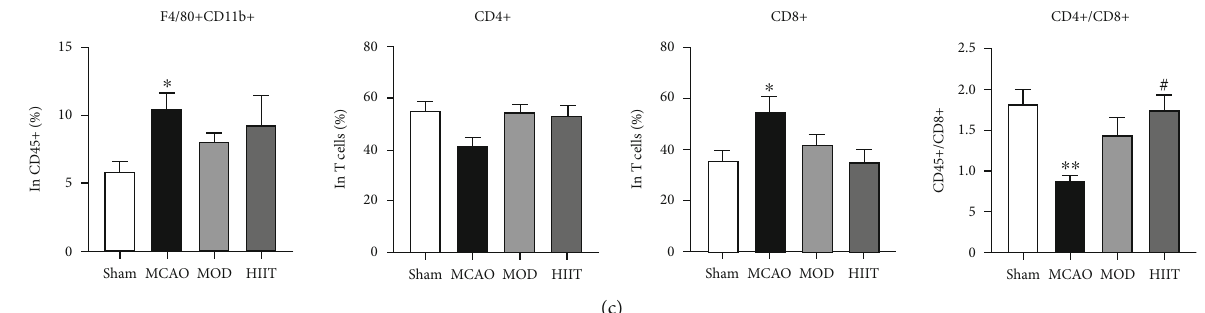
Figure 8: Level of cytokines in paretic skeletal muscle and lymphocyte subsets in peripheral blood. (a) The pro fi les of multiple cytokines in paretic gastrocnemius muscle in each group, including interleukin- (IL-) 1 α , IL-1 β , IL-6, IL-10, IL-27, monocyte chemoattractant protein (MCP-1), tumor necrosis factor- (TNF-) α , and interferon- (IFN-) γ . (b) Representative fl uorescence activated cell sorting (FACS) plots of F4/80+CD11b+ macrophages gated on CD45+ cells, CD4+ cells gated on CD45+CD3+ cells, and CD8+ cells gated on CD45+CD3 +cells in muscle tissue. (c) Bar graph showing the percentage of F4/80+CD11b+ cells in CD45+ cells, CD4+ cells in CD45+CD3+ cells, CD8+ cells in CD45+CD3+ cells, and the ratio of CD4+ and CD8+ cells. Values are expressed as the mean ± SEM of the mean. ∗ P < 0 : 05 and ∗∗ P < 0 : 01 compared with the sham group; # P < 0 : 05 and ## P < 0 : 01 compared with the MCAO group; + P < 0 : 05 and ++ P < 0 : 01 compared with the MOD group as determined by one-way ANOVA (Tukey ’ s multiple comparison test) for the data with normal distribution. The letters for no signi fi cance were not